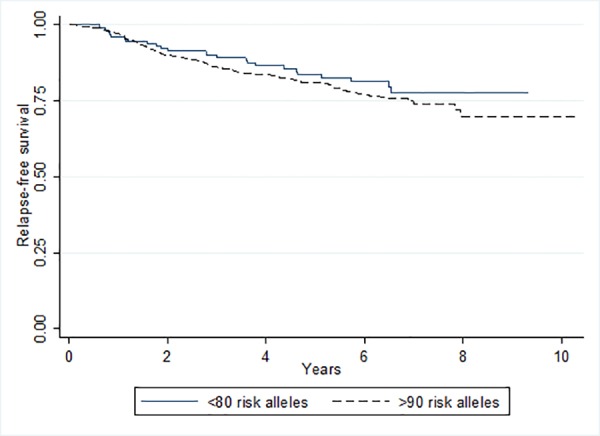
Kaplan-Meier plot comparing relapse-free survival in patients carrying >90 risk alleles to those carrying <80 risk alleles.